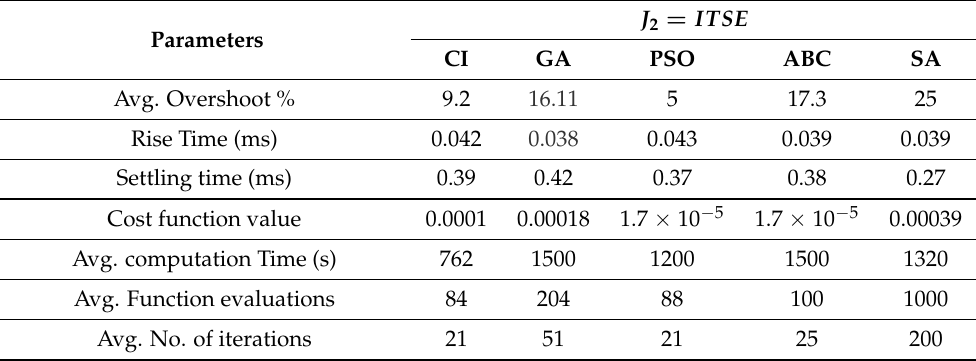
Table 5. Comparison of different optimization methods for the cost function ITSE.